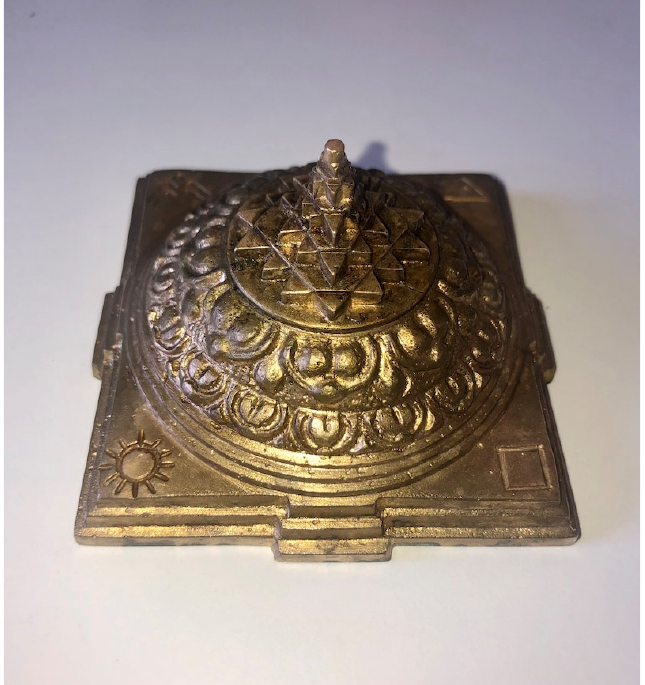
Figure 7. Lalit ā ’s yantra , the Ś r ī cakra, in three-dimensional form. Credit: author. Figure 7. Lalit¯a’s yantra , the ´Sr¯ıcakra, in three-dimensional form. Credit: